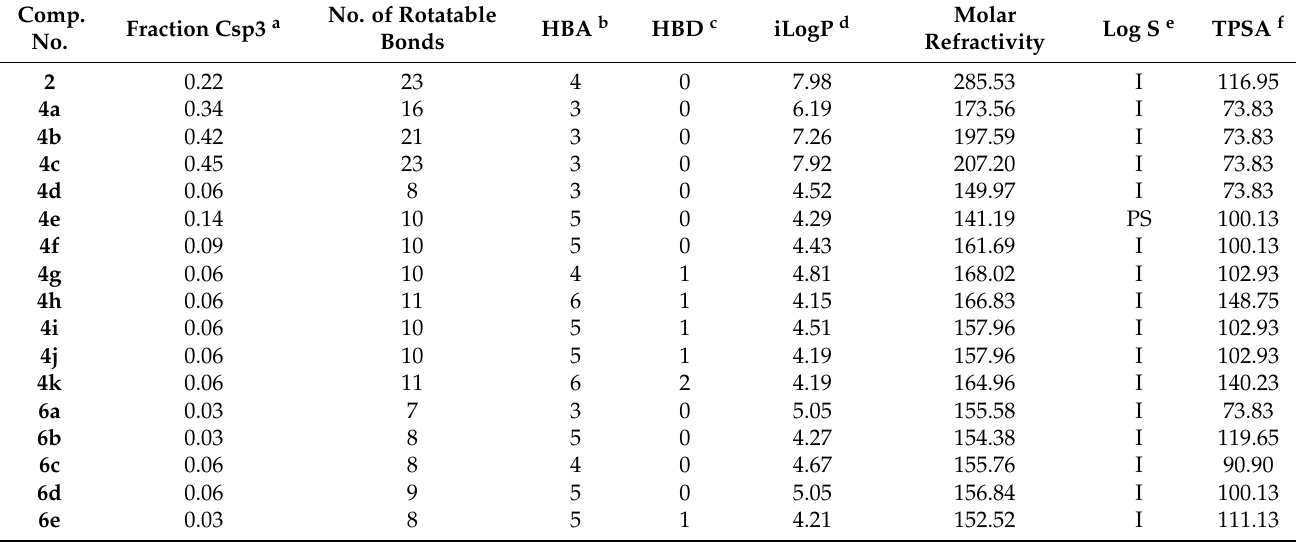
Table 2. Physicochemical properties of the selected